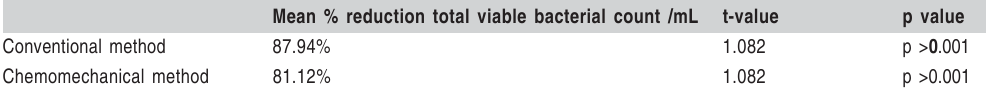
Table 4 - Mean reduction in total viable bacterial count after use of the chemomechanical and conventional methods of caries